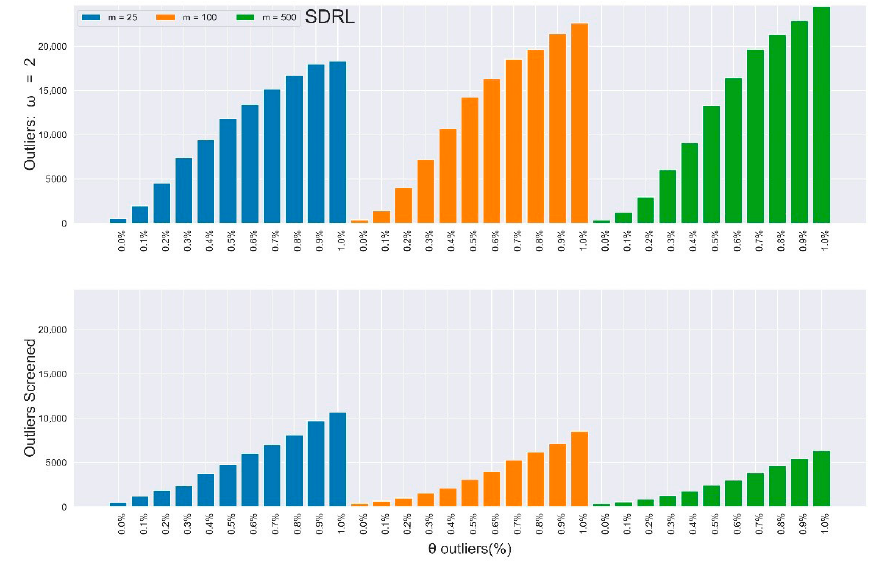
Figure 5. In-control SDRL values of the multivariate Shewhart chart from a mixed distribution with and without SDRE multivariate outliers screening ((cid:2033) = 2) .